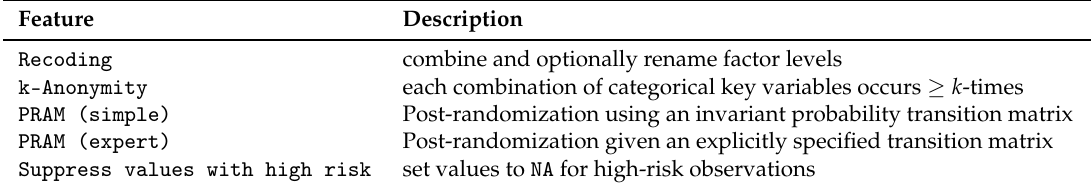
Table 5. Anonymization methods for categorical